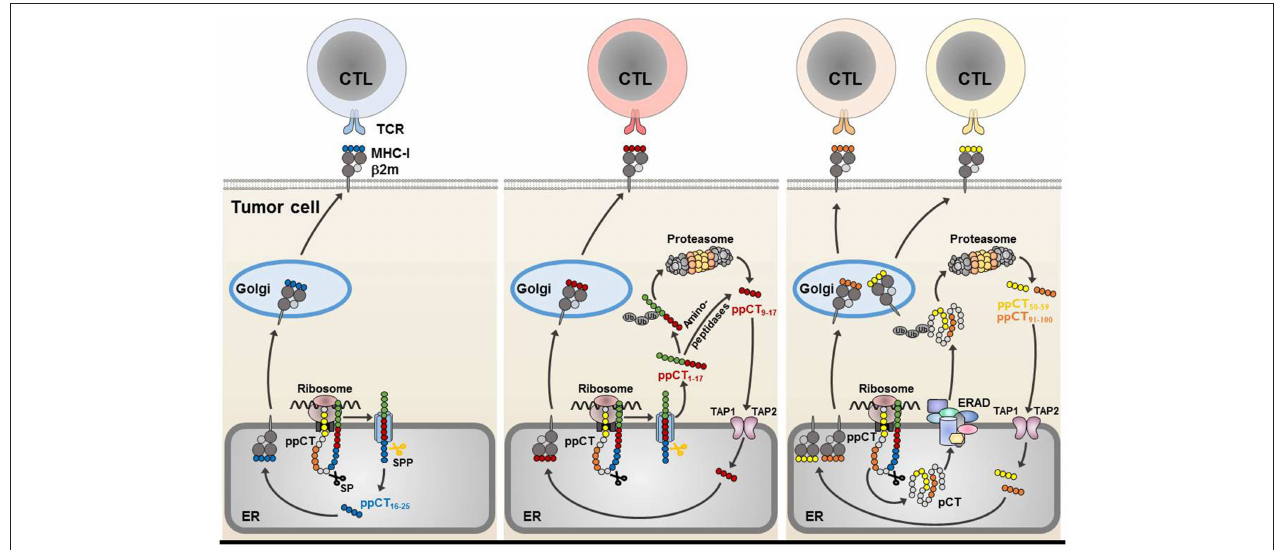
FIGURE 1 | Processing of CD8 ppCT T-cell epitopes. The ppCT signal peptide has a type II orientation (the NH2-terminal region exposed toward the cytosol and the COOH-terminal region facing the endoplasmic reticulum lumen). The ppCT 16 − 25 epitope is processed by SP and SPP independently of TAP, and is released directly into the endoplasmic reticulum (left) . After cleavage by SP and SPP, a ppCT 1 − 17 signal peptide fragment is released into the cytoplasm, to be processed by the proteasome/TAP pathway so as to give rise to the ppCT 9 − 17 epitope. The ppCT 9 − 17 epitope may also be generated from a ppCT 1 − 17 signal peptide fragment by cytosolic proteases before transport into the endoplasmic reticulum lumen by TAP (middle) . ppCT 50 − 59 and ppCT 91 − 100 epitopes are generated by the TAP/proteasome pathway after retrotranslocation of the pCT precursor protein from the endoplasmic reticulum lumen into the cytosol by the ERAD pathway (right) . All generated ppCT epitopes bind within the endoplasmic reticulum to HLA-A2 molecules before externalization to the target cell membrane for recognition and elimination by specific CD8T lymphocytes. ER, endoplasmic reticulum; MHC-I, MHC-class I; Ub,